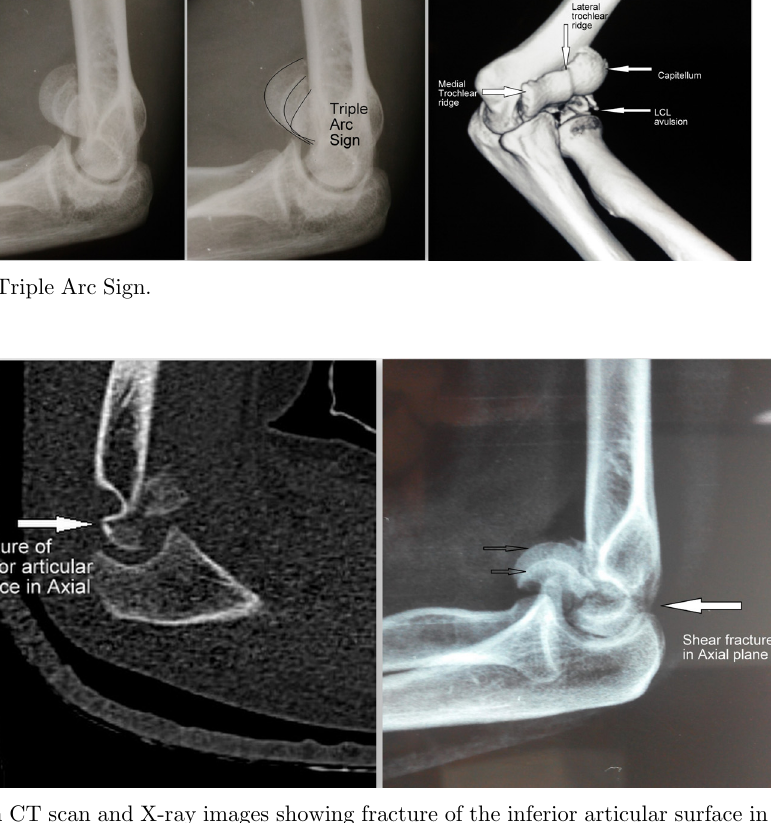
Figure 10. Sagittal section CT scan and X-ray images showing fracture of the inferior articular surface in axial